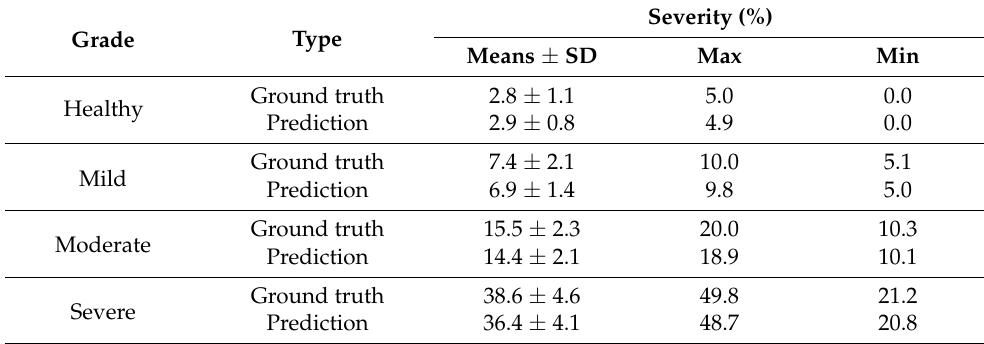
Table 5. Statistical results of wheat spike FHB disease severity for four grades.